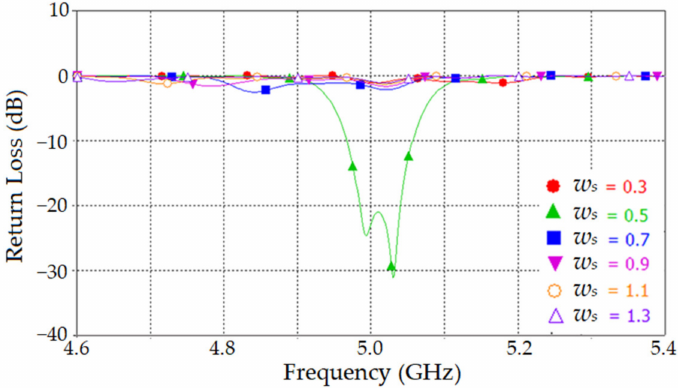
Figure 6. Simulated return loss for different values of ‘ w s ’.